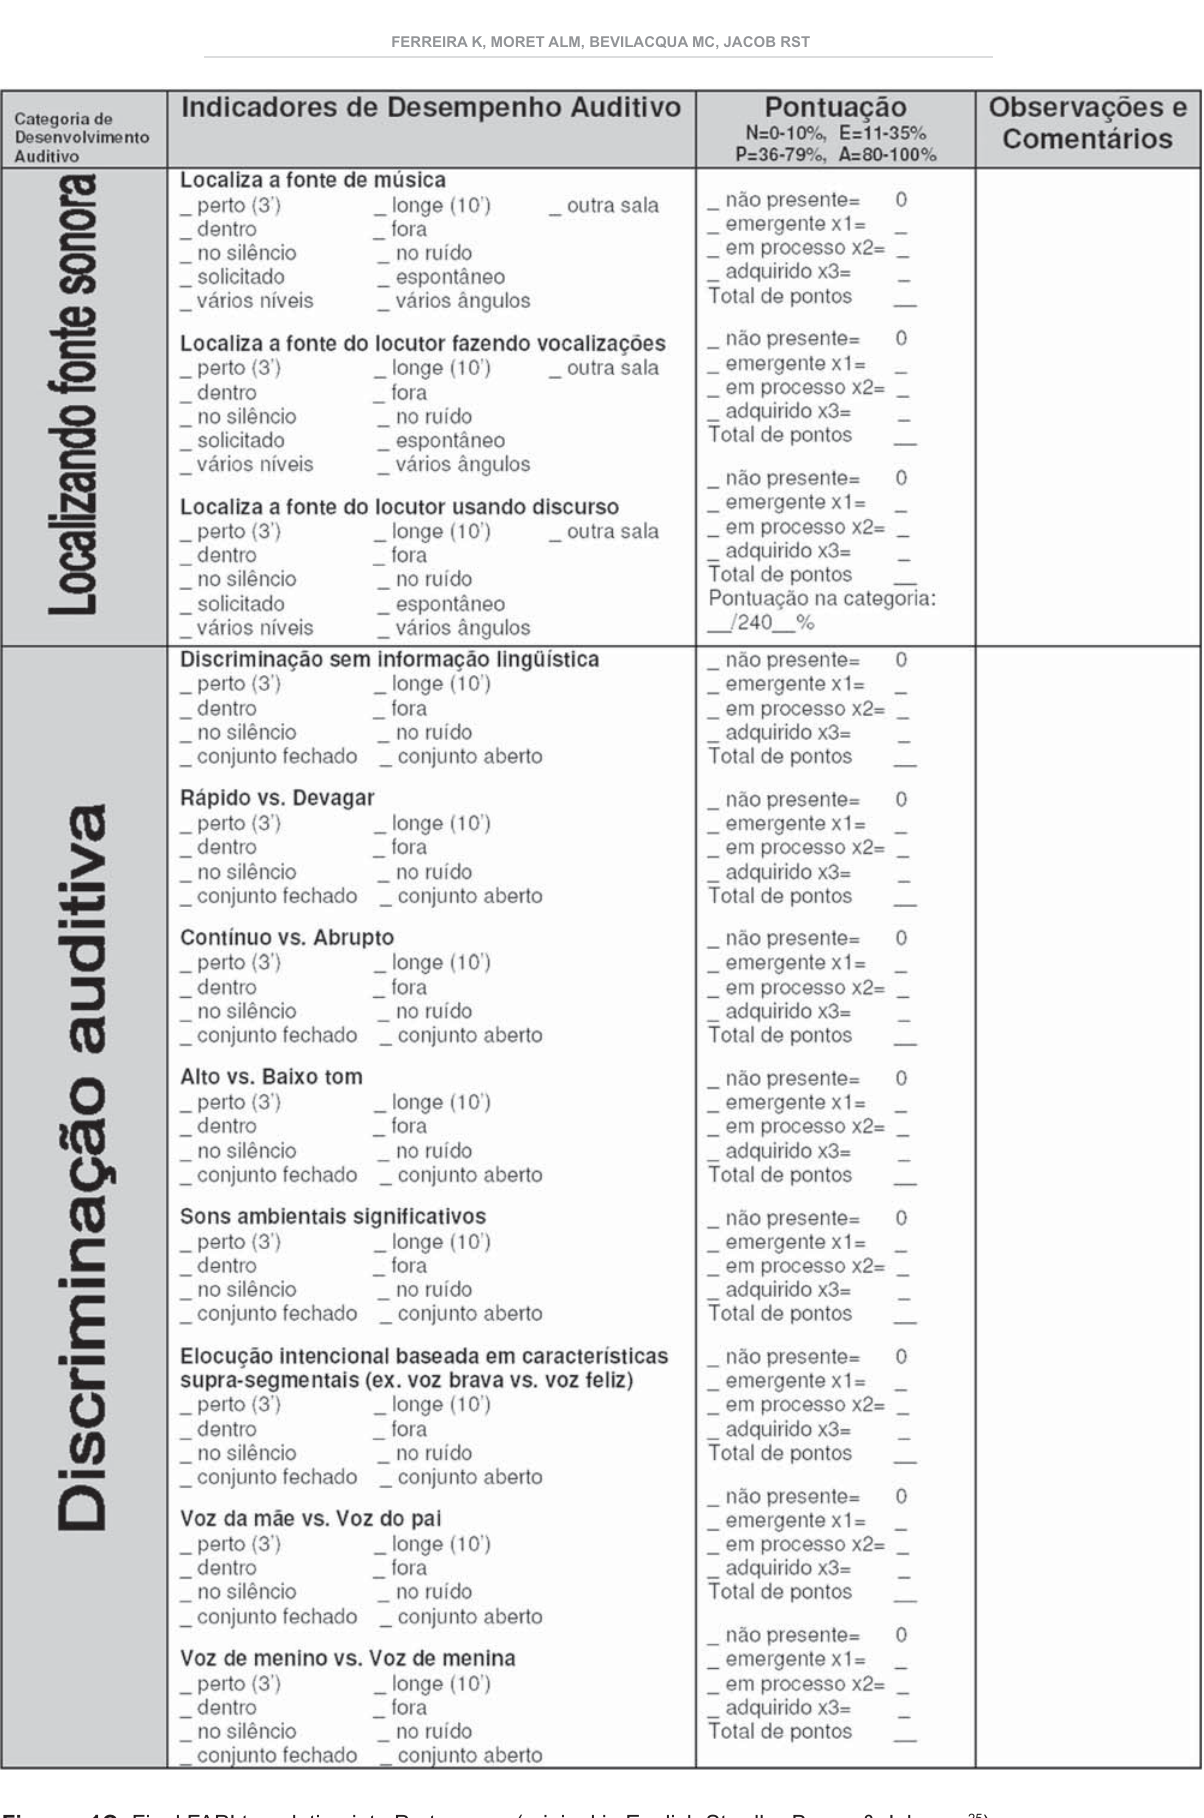
Figures 1C- Final FAPI translation into Portuguese (original in English:Stredler-Brown & Johnson 25